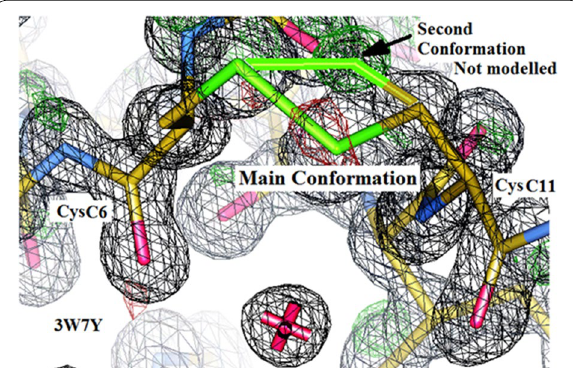
Fig. 16 Electron density in Intergen (II) (3W7Y) in the vicinity of the disulphide bridge in chain C CysC6–CysC11. The presence of green density ( arrowed ) suggests the existence of a second conformation, as in the Insugen (I) structure. This second, minor, conformation has not been modelled in deposited Intergen (II) structure. Drawn with WinCoot 0.7